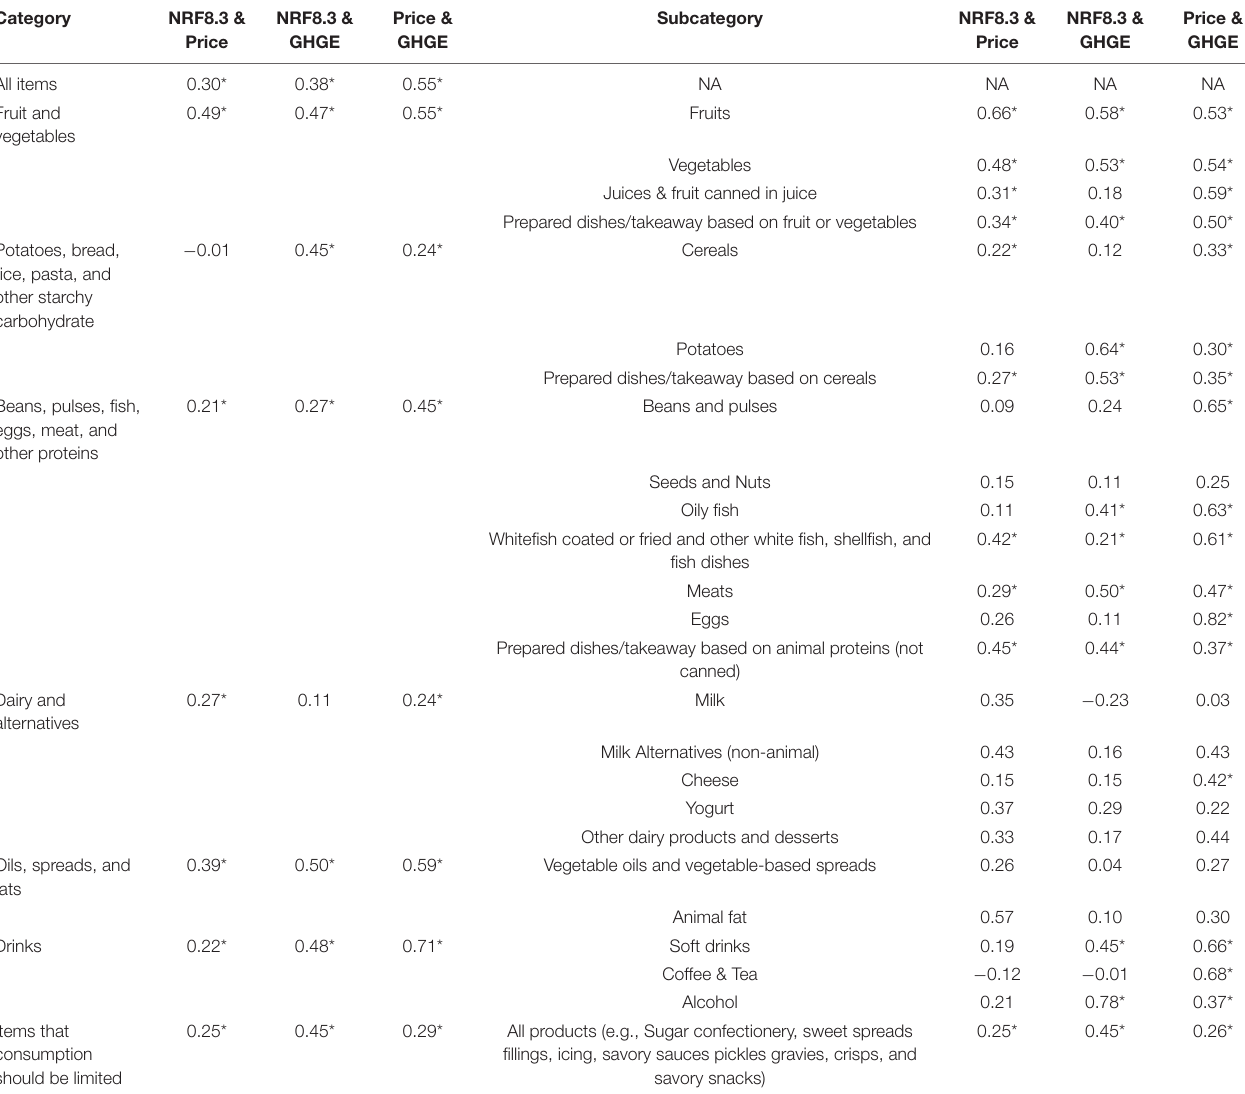
TABLE 3 | Correlation between NRF8.3, GHGE, and price